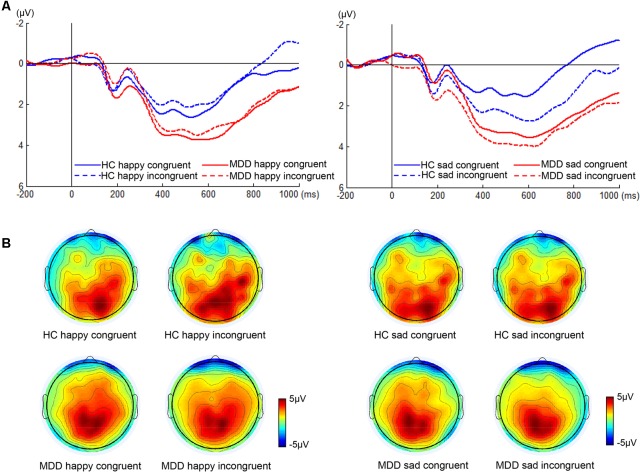
ERP waveforms and scalp topographies of P300. The waveforms were averaged across electrodes CPz and Pz to reflect the P300 ANOVA findings (A). The corresponding scalp topographies elicited by the target congruent stimuli and incongruent stimuli were obtained for a 20-ms long time interval around the latencies of the P300 peaks (B).